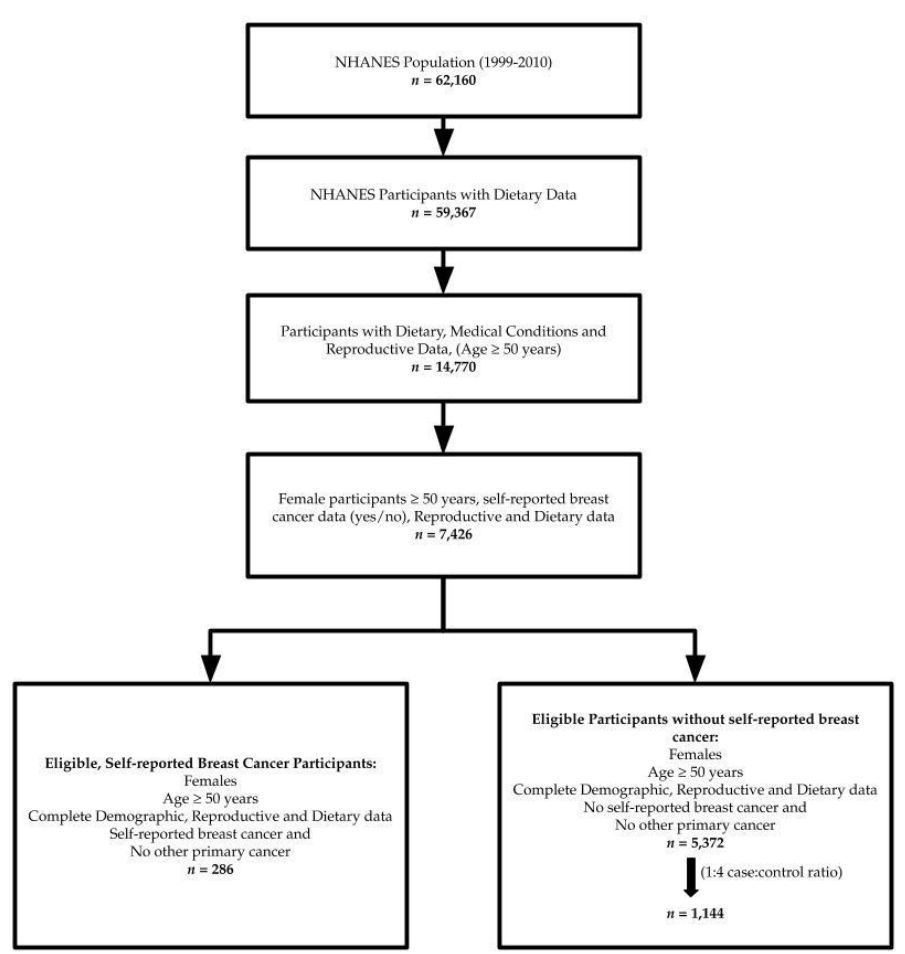
Figure 1. Flowchart of study participants.